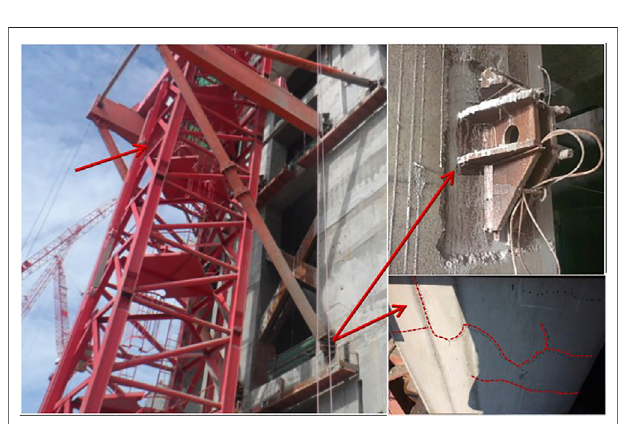
FIGURE 2 | BFJ of tower crane and cracks.